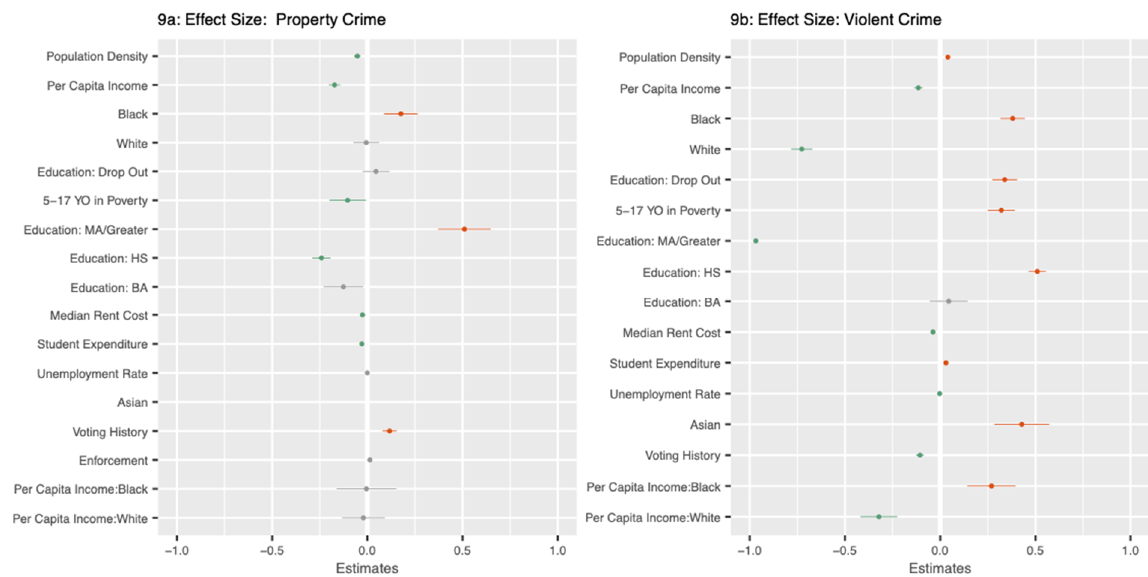
Figure 9. Standardized coefficient values controlling for interactions among significant covariates and crime type, as well as three-way interactions among black/white race variables, per capita income, and crime type. We removed both population and Asian variables to make other values more visible: their respective values are 1.18 and − 1.1 for property crime and − 0.14 and − 0.11 for violent crime. Note that in order to get the violent coefficients one must add the corresponding property crime value to the violent crime value (for instance, to obtain the population value for violent crime, one would add − 0.14 to 1.18 and get a final value of 1.04).